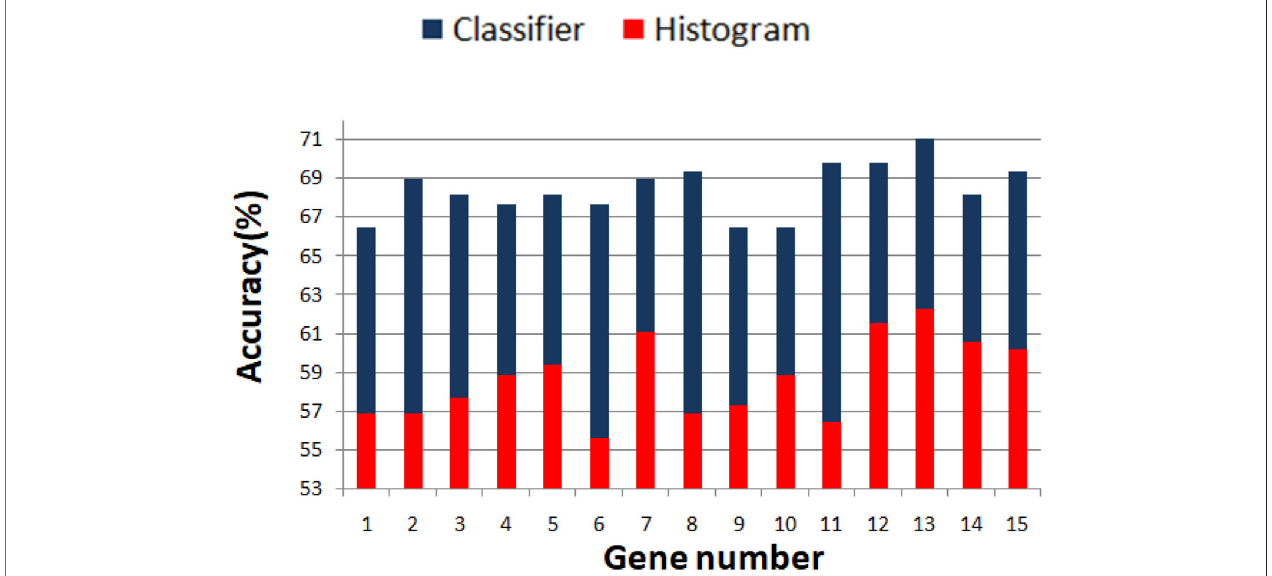
FIGURE 6 | Comparison between the accuracy of predictions of the result of drug therapy based on the histogram of gene expression values (red bars) and the optimized network of oscillators (blue bars). The gene numbers correspond to these in Table 1 .